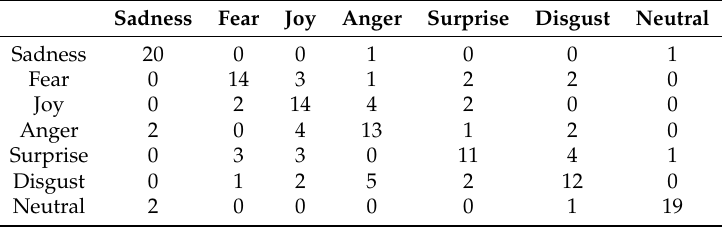
Table A11. P11 actor confusion matrix from the RekEmozio dataset in the second phase.